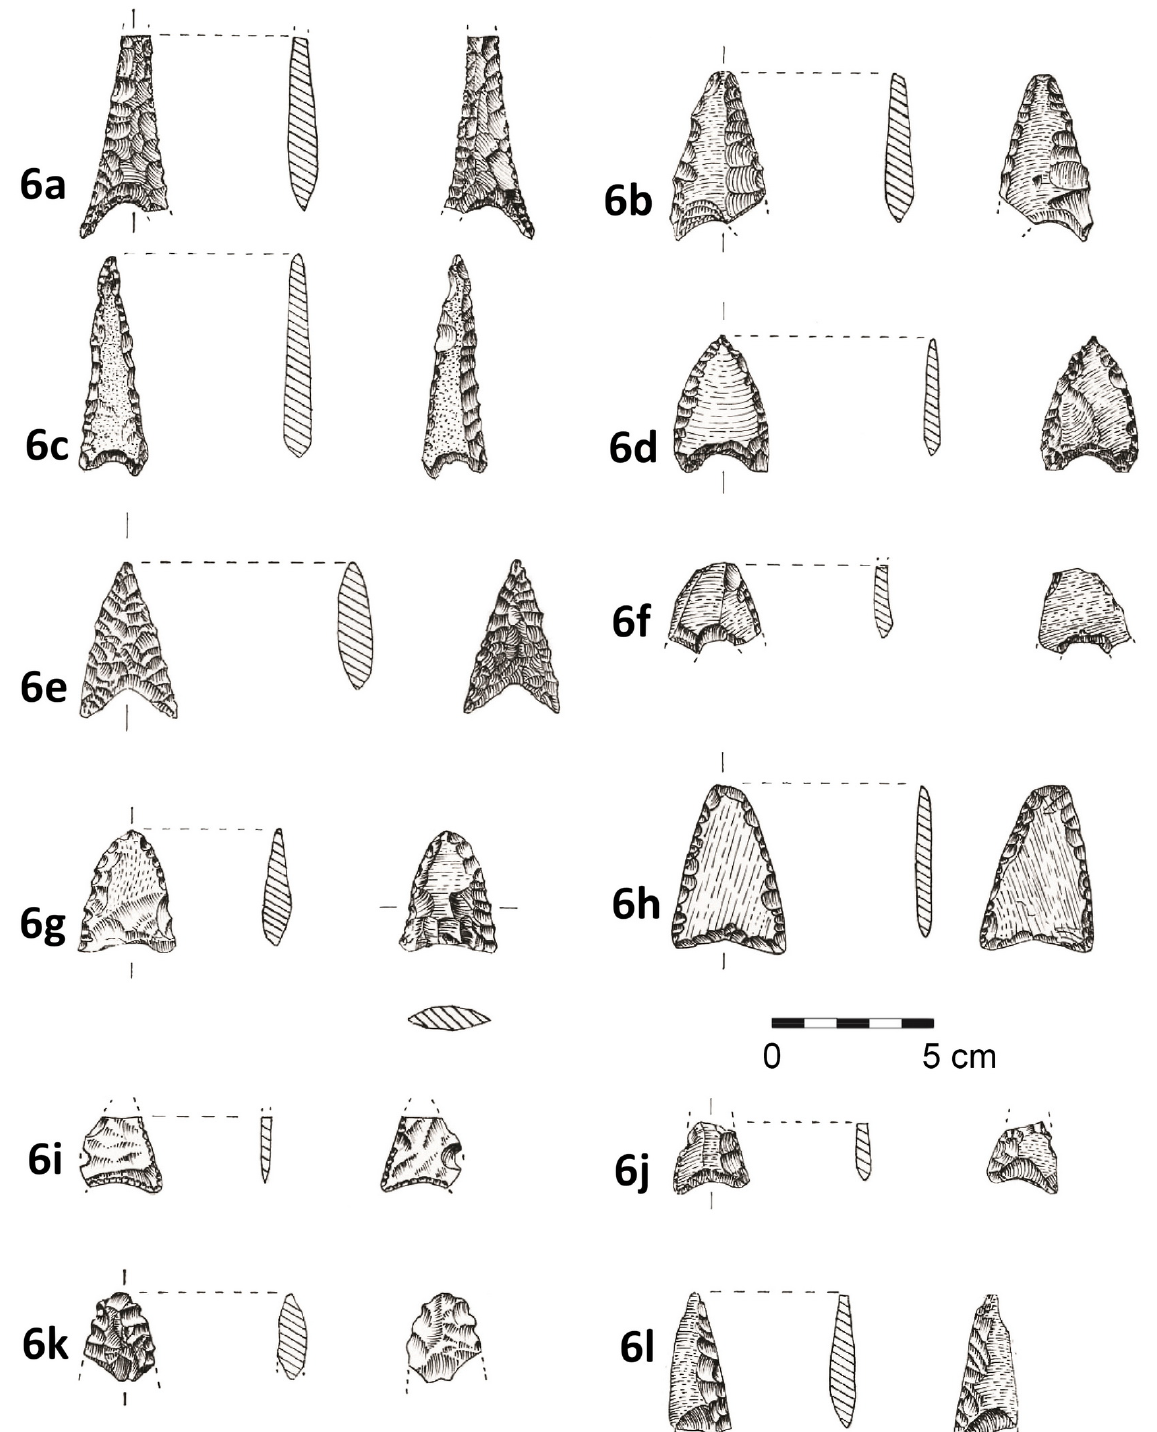
Figura 6. Ponta de seta tipo torre Eiffel em sílex (6a); pontas de seta triangulares de base côncava em sílex (6b a 6g, 6i e 6j); ponta de seta triangular de base côncava em xisto silicificado (6h); pontas de seta triangulares de base indeterminada em sílex (6j a 6l). Desenhos de Leonel Trindade Jr. Figure 6. Eiffel tower type flint point (6a); concave base triangular flint arrow point (6b to 6g, 6i and 6j); concave base triangular silicified xist point (6h); undetermined base triangular flint point (6j to 6l). Drawing by Leonel Trindade